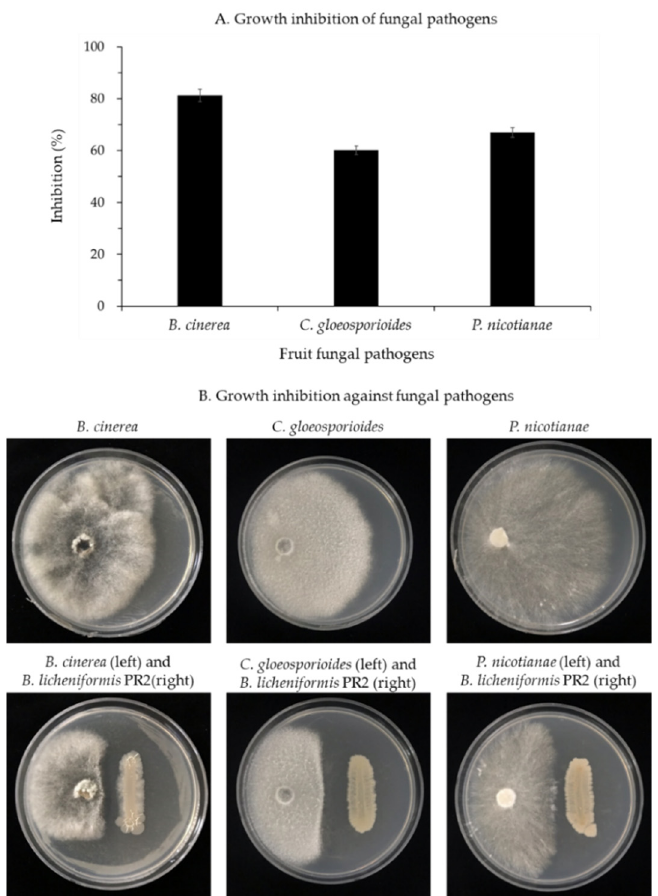
Figure 3. ( A ) Inhibition of mycelial growth and ( B ) antagonistic activity of B. licheniformis PR2 against fungal pathogenic B. cinerea , C. gloeosporioides, and P. nicotianae by the dual culture method.